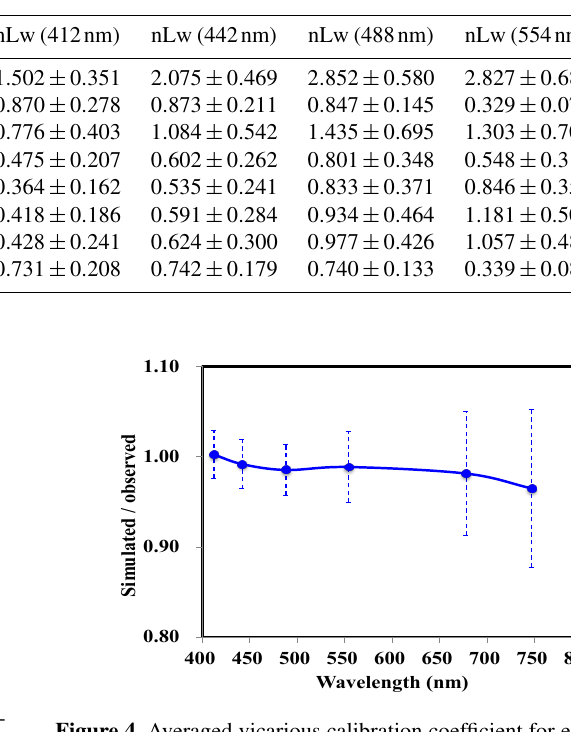
Figure 4. Averaged vicarious calibration coefficient for each chan-